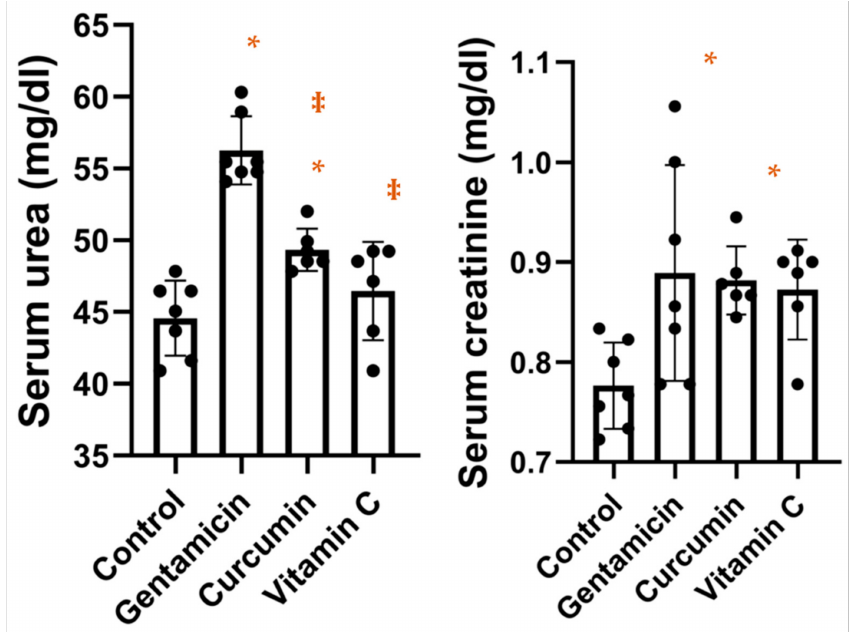
Figure 1. Box-plot showing serum urea and creatinine concentrations in our study groups (* p < 0.05 vs. control; ‡ p < 0.05 vs.